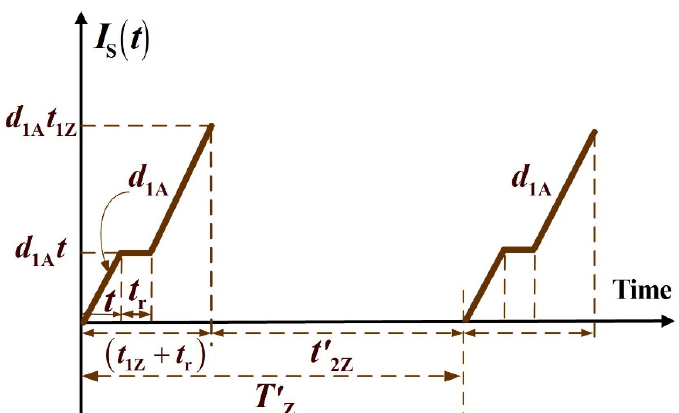
Fig. 3. The scrap product level in condition